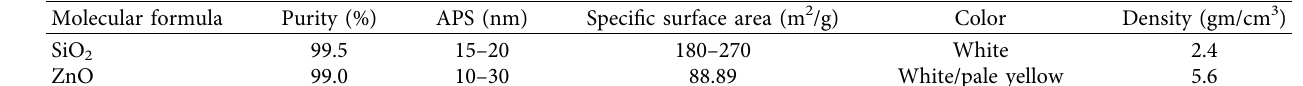
Table 4: Characterization of SiO